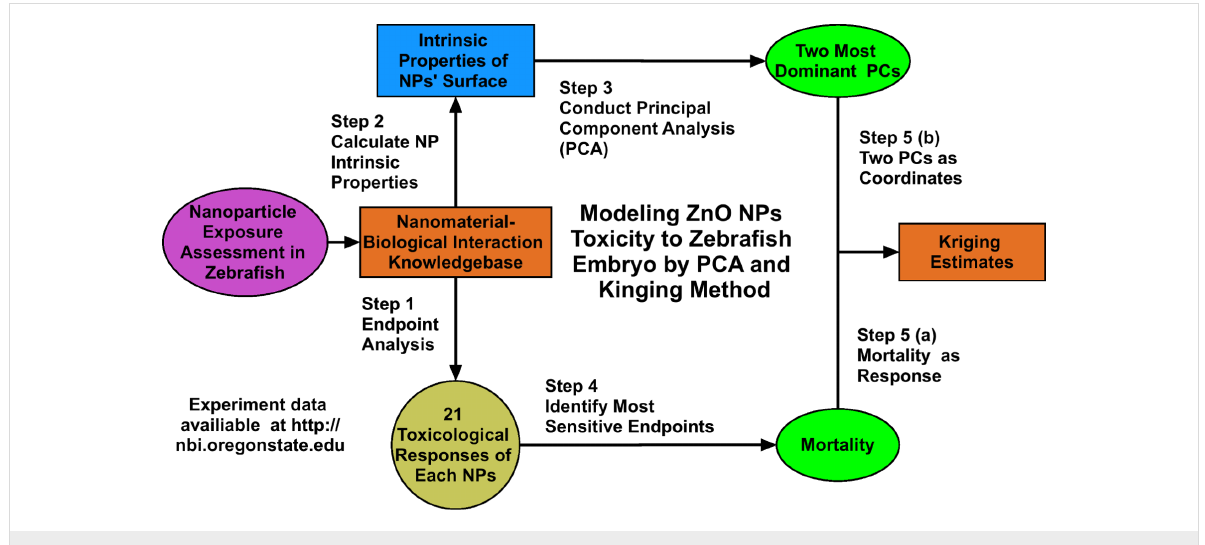
Figure 1: Data processing for model